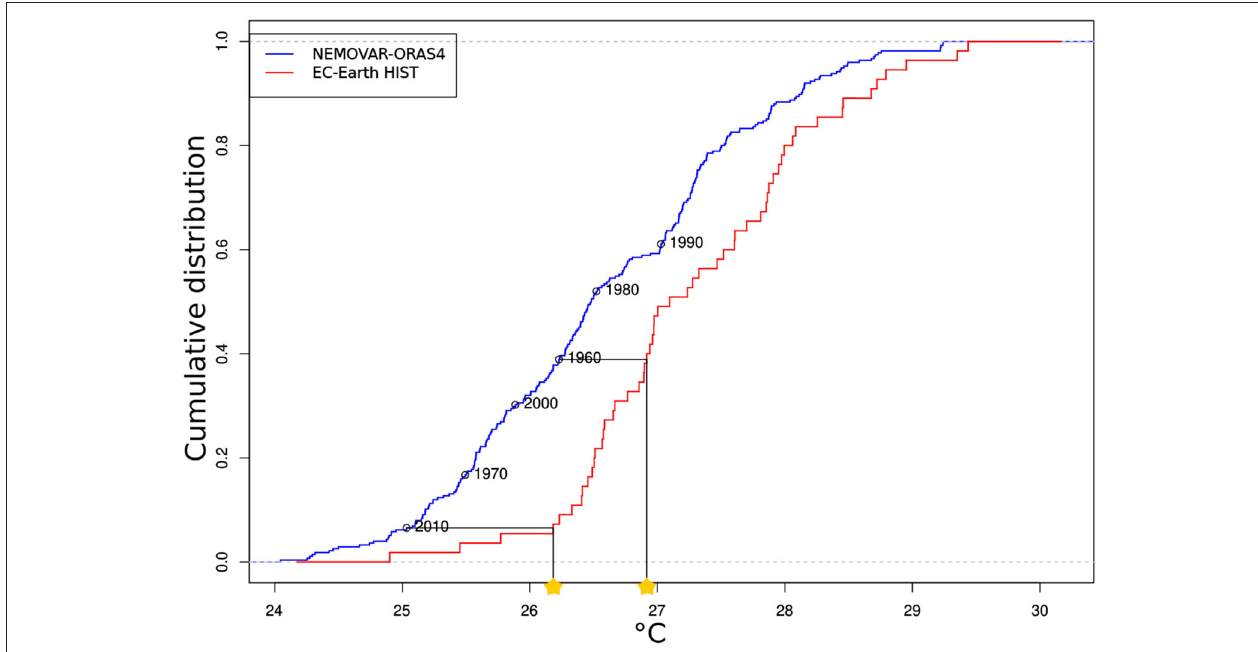
FIGURE 1 | Example of the implementation of the quantile matching method: cumulative distribution function for the SST in one grid point of the Tropical Pacific in blue for NEMOVAR-ORAS4 and in red for a historical simulation of EC-Earth3. The circles in the reanalysis distribution indicate the value on November 1 of the year indicated in the figure. The prediction at that grid point will be initialized with the value from the historical simulation, which has the same cumulative distribution as NEMOVAR-ORAS4 at the initialization time (the yellow stars indicate the value for the start dates of 1960 and 2010). This calculation is made for all the grid points and all the ocean prognostic variables.